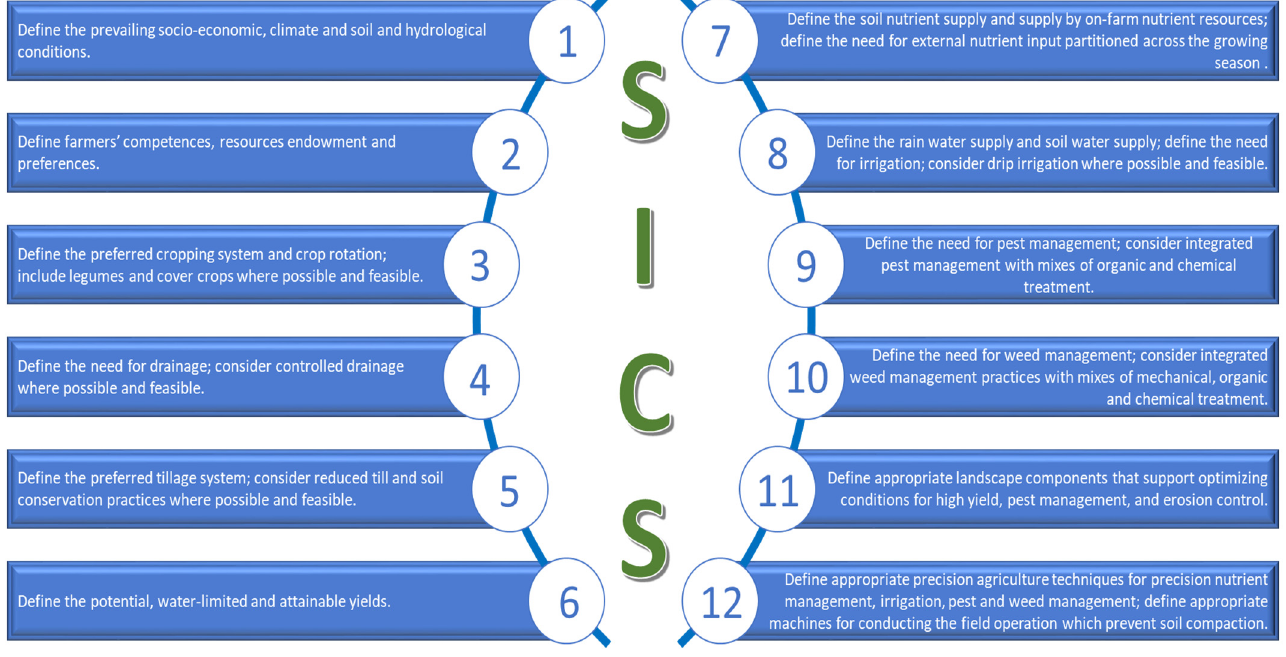
Figure 7. Towards sustainable cropping systems; a step-wise roadmap for developing high-yielding, soil-improving and environmentally sound cropping systems. The steps (1 to 12) have to be taken in a consecutive-iterative manner so as to find the optimal combination of practices.